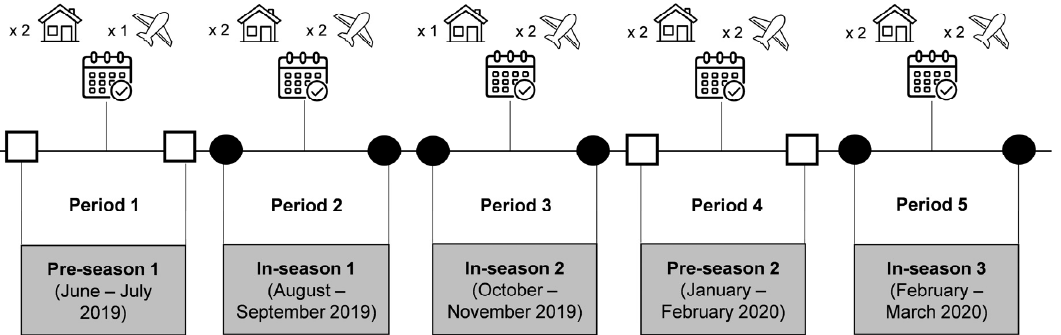
Figure 1. Distribution of periods throughout the season. For each period the number of the analysed matches played at home (home symbol) and away (airplane symbol) are shown.